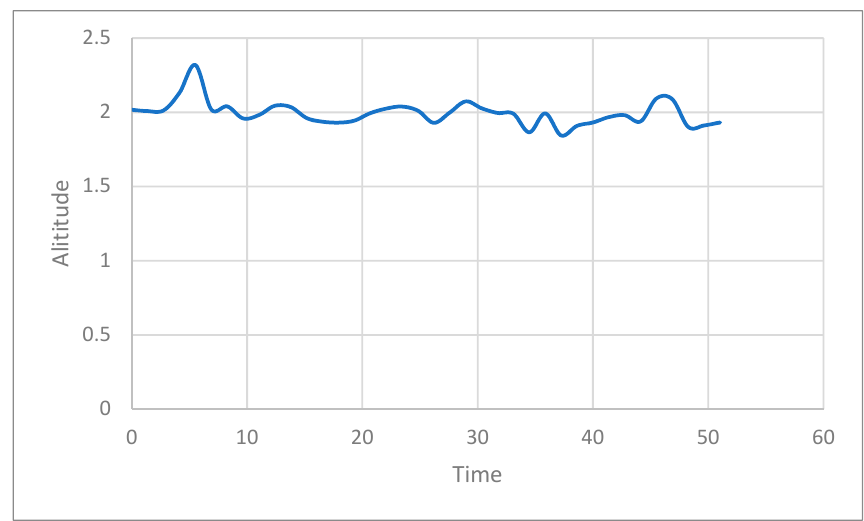
Figure 19. UAV flight altitude with security framework in nonnative ROS.